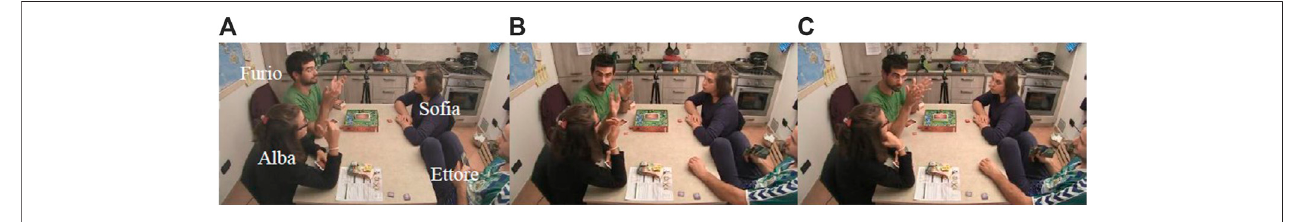
FIGURE1| FramesfromExtract(4). (A) Albahelps,Furiodoesn ’ t,inresponsetoSo fi a ’ squestion(line9). (B) FuriointervenestostopAlbahelpingSo fi a(line10). (C) Furio turns to Ettore during impersonal TCU (line